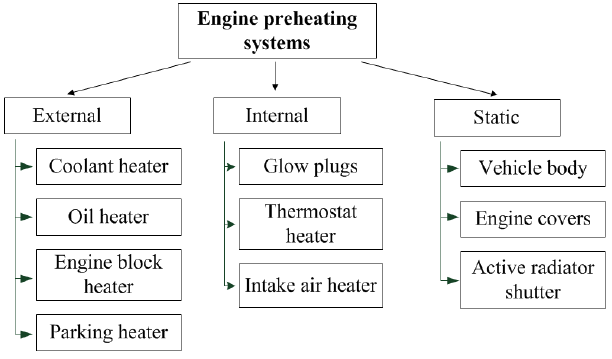
Fig. 1. Combustion engine coolant heat accumulators, pre-heating and temperature maintenance